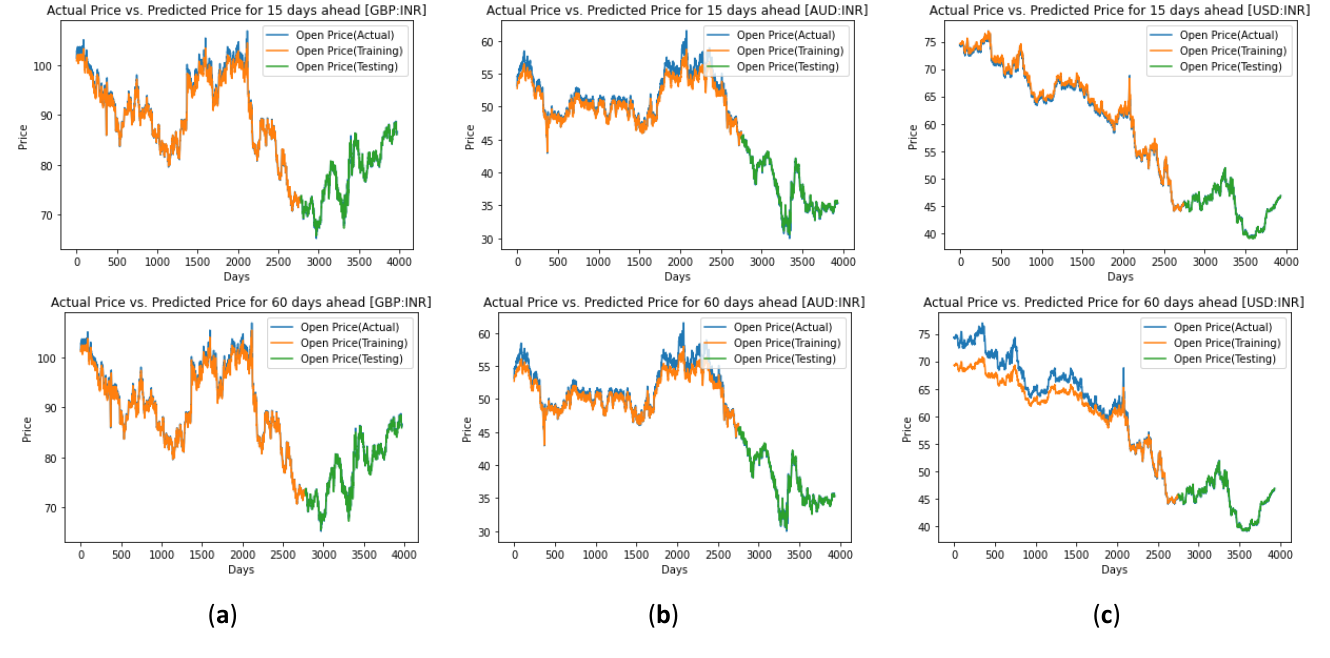
Figure 3. Short-term and long-term prediction graphs and MSE graphs using Vanilla-LSTM for ( a )